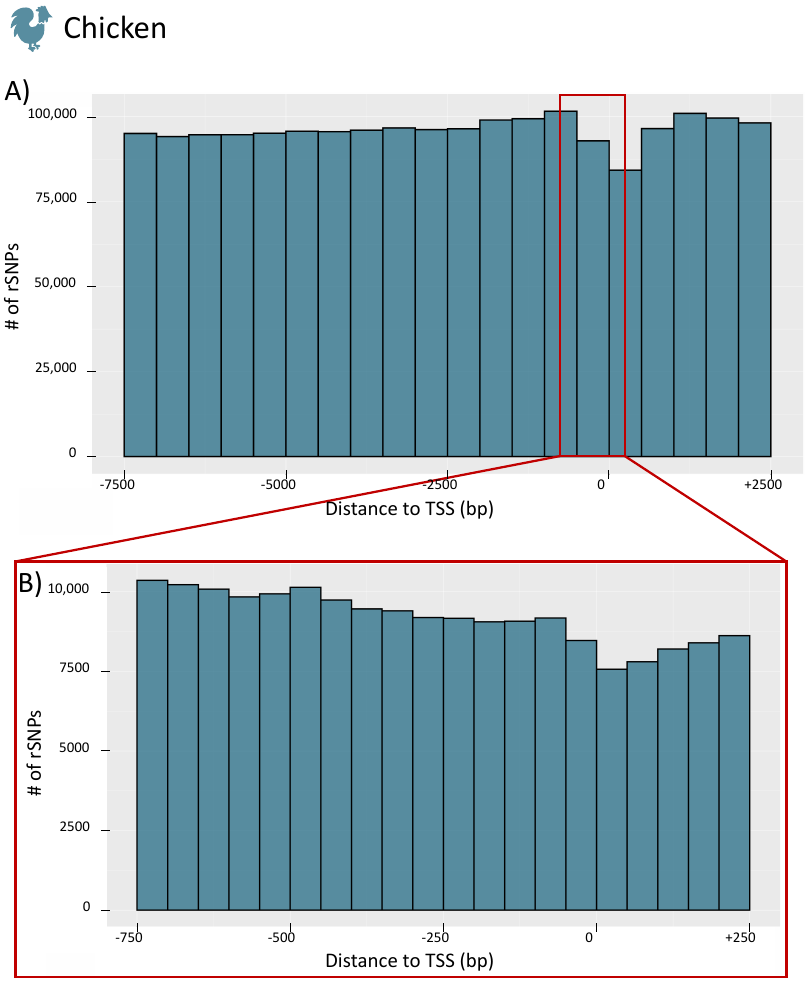
Figure 7. Distribution of the distances between rSNPs and the TSS of chicken. ( A ) The counts for the whole promoter region ( − 7.5 kb to +2.5 kb) in 500 bp intervals. The enlargement in ( B ) shows the proximal promoter region ( − 750 bp to +250 bp) in 50 bp